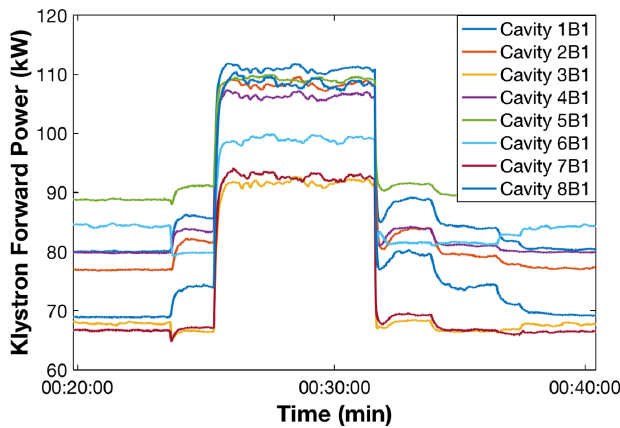
FIG. 10. Average klystron forward power. 204 bunches, beam